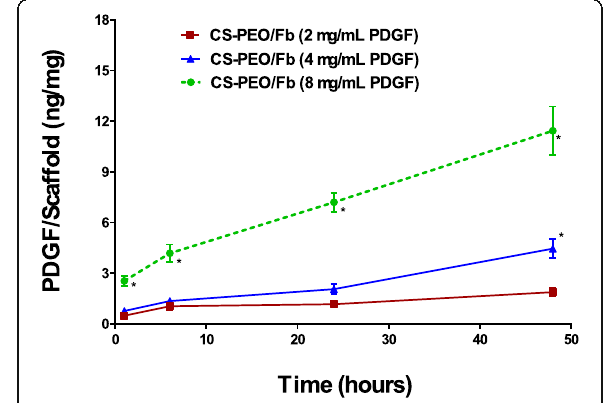
Fig. 11 PDGF is released from CS-PEO/Fb scaffolds for up to 48 h in a dose-dependent manner ( n = 10, * p < 0.05 when compared to 2 μ g/mL of PDGF dosage at each specific time point, # p < 0.05 when compared to 4 μ g/mL of PDGF dosage at each specific time point)